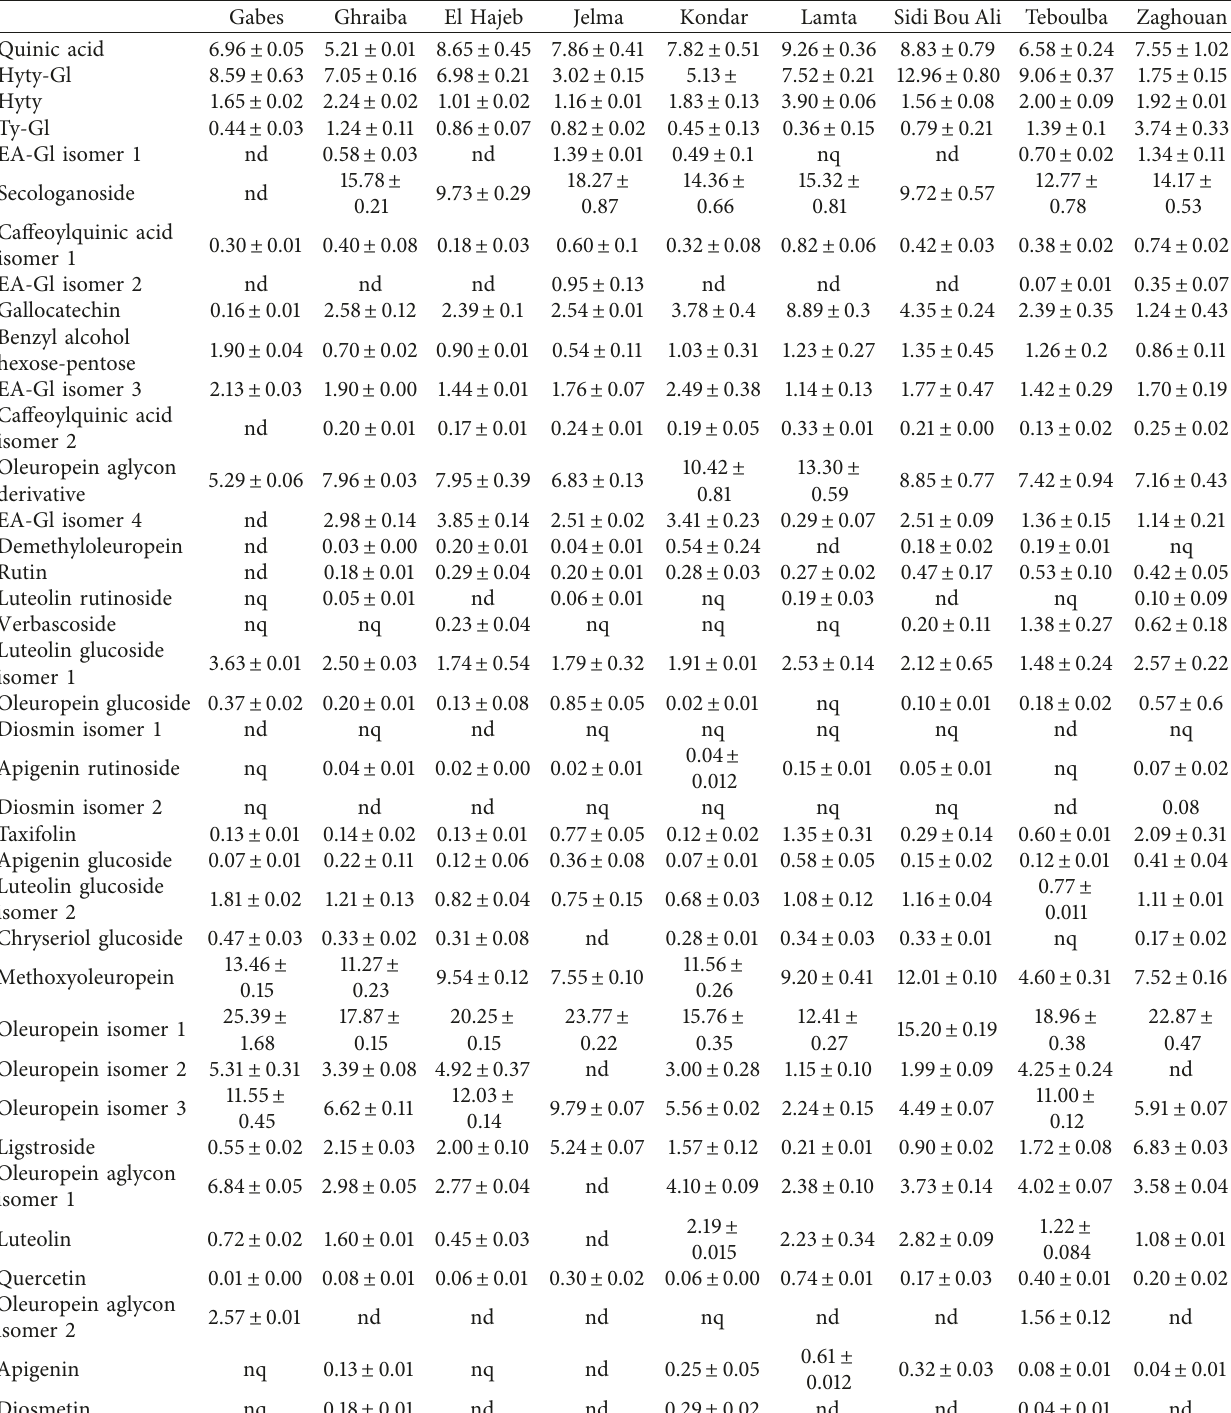
Table 2: Phenolic composition (in % of total phenolics) of “Chemlali” olive leaves from different